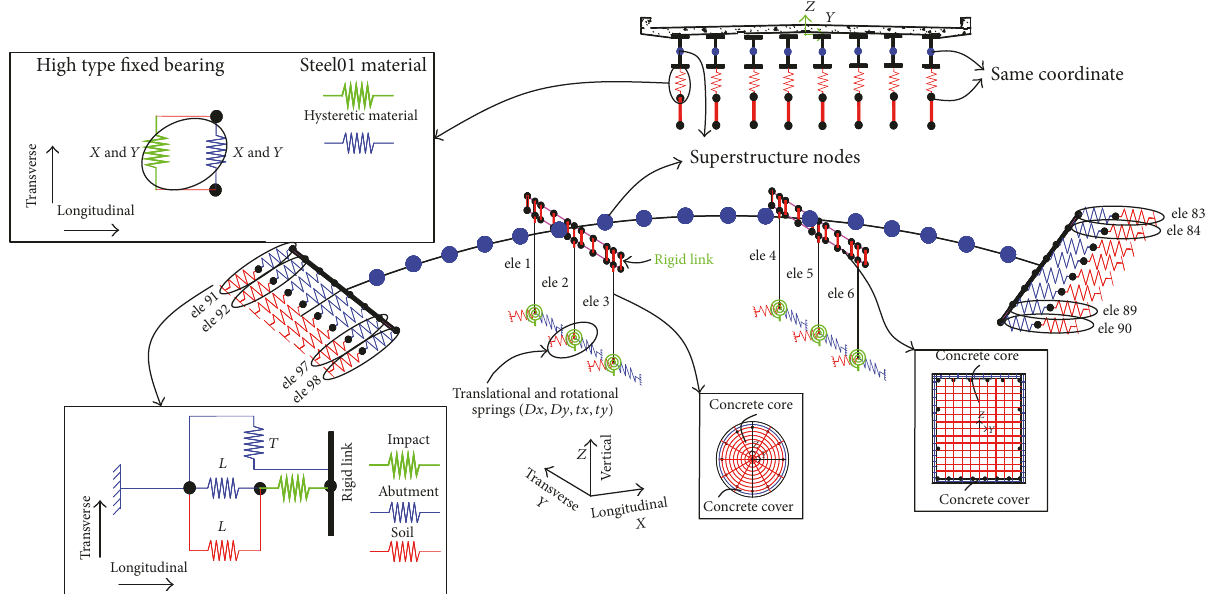
Figure 7: Finite element model of horizontal steel curved